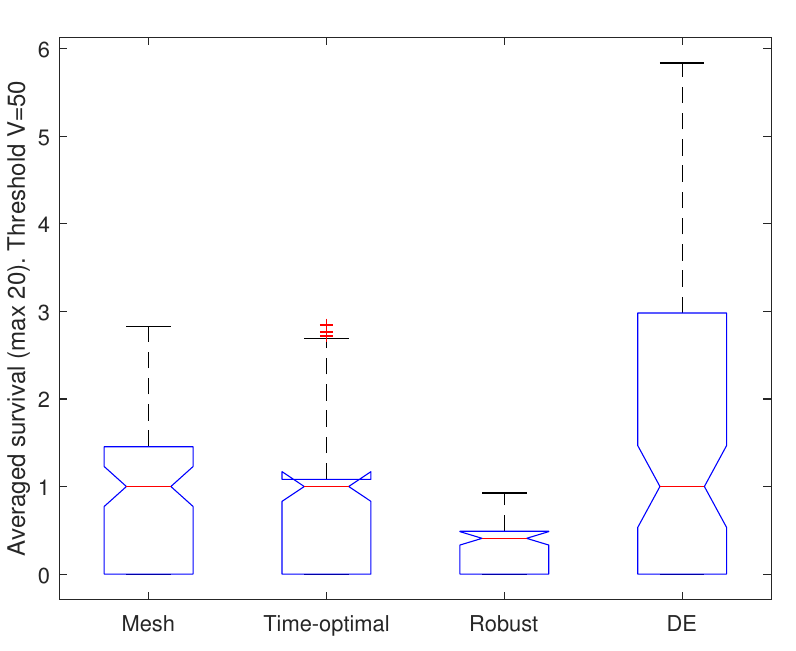
Figure 4. Boxplot of the results obtained in